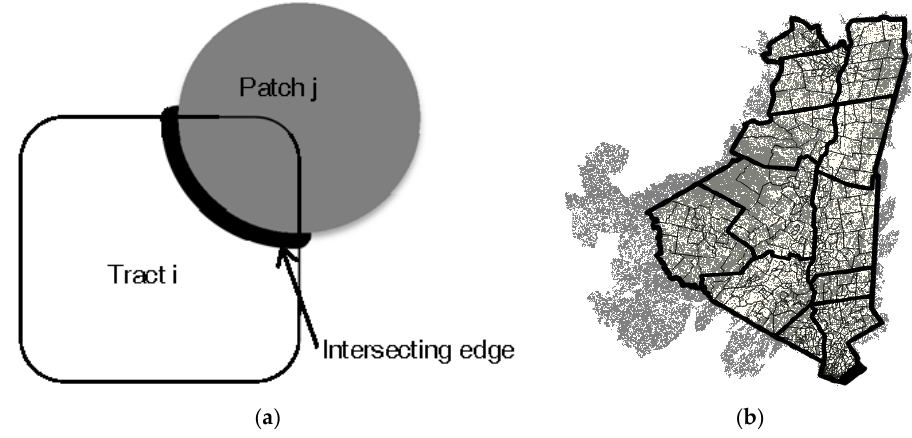
Figure 2. Model schematic and data. ( a ) Cartoon of model. The square represents the peridomestic region being considered. The gray circle represents an intersecting forest patch. When calculating entomological risk, the entire gray region is considered, as the patch’s entomological risk is a product of total area rather than area falling within the peridomestic region. When calculating exposure risk, only the portion of perimeter falling within the peridomestic region is considered (illustrated by bolded portion of perimeter); ( b ) Study landscape, including perimeter of 12-county region, 1.6 km buffer (black outer border in image), and intersecting forest patches (gray raster cells) derived from the National Land Cover Database 2011.